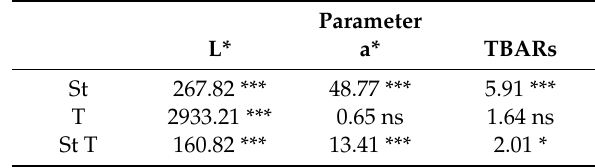
Table 2. F value and relative significance of the influence of storage time (St) and temperature (T) and their interaction (St T) on color parameters (L* and a*) and lipid oxidation (TBARs) data of fresh mantis flesh obtained by manual and mechanical separation.